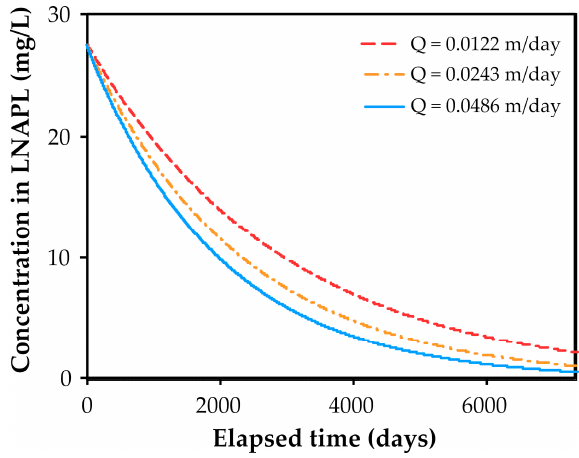
Figure 7. Decline of the benzene concentration in LNAPL as a function of flow rate (Q).